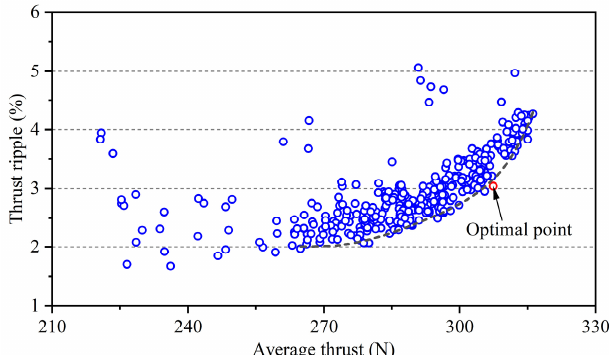
Figure 5. Multi ‐ objective optimization of DCB ‐ VRLM with non ‐ uniform air gap using NSGA ‐ II algorithm.